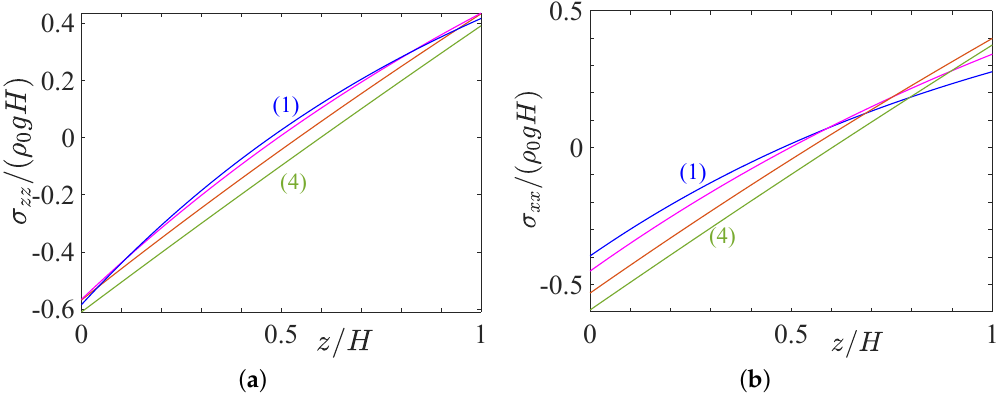
Figure 3. Illustration of stresses ( a ) σ zz and ( b ) σ xx induced by gravity combined with a temperature gradient. (1) ( κ , Λ , Ψ ) = ( 0.0204,1.092,0.849 ) , (2) ( 0.0340,1.652,1.416 ) , (3) ( 0.102,4.477,4.247 ) and (4) ( 0.204,8.723,8.495 )